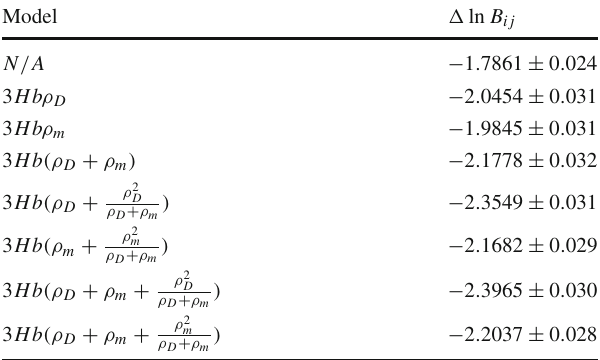
Table7 ThestrengthofJefrey’sscaleln B ij forholographicRIccidark energy model (HRDE) compared to (cid:3) CDM model. The negative sign demonstrates that the (cid:3) CDM is superior to HRDE model Model